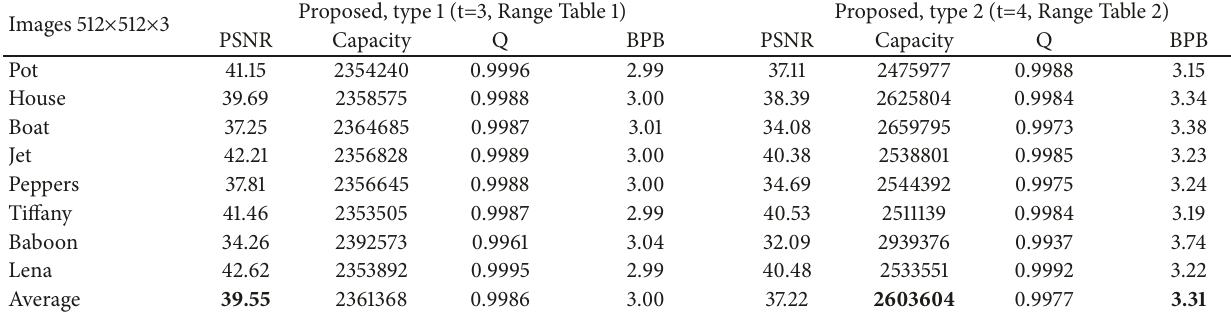
Table 5: Results of proposed eight-directional PVD technique.